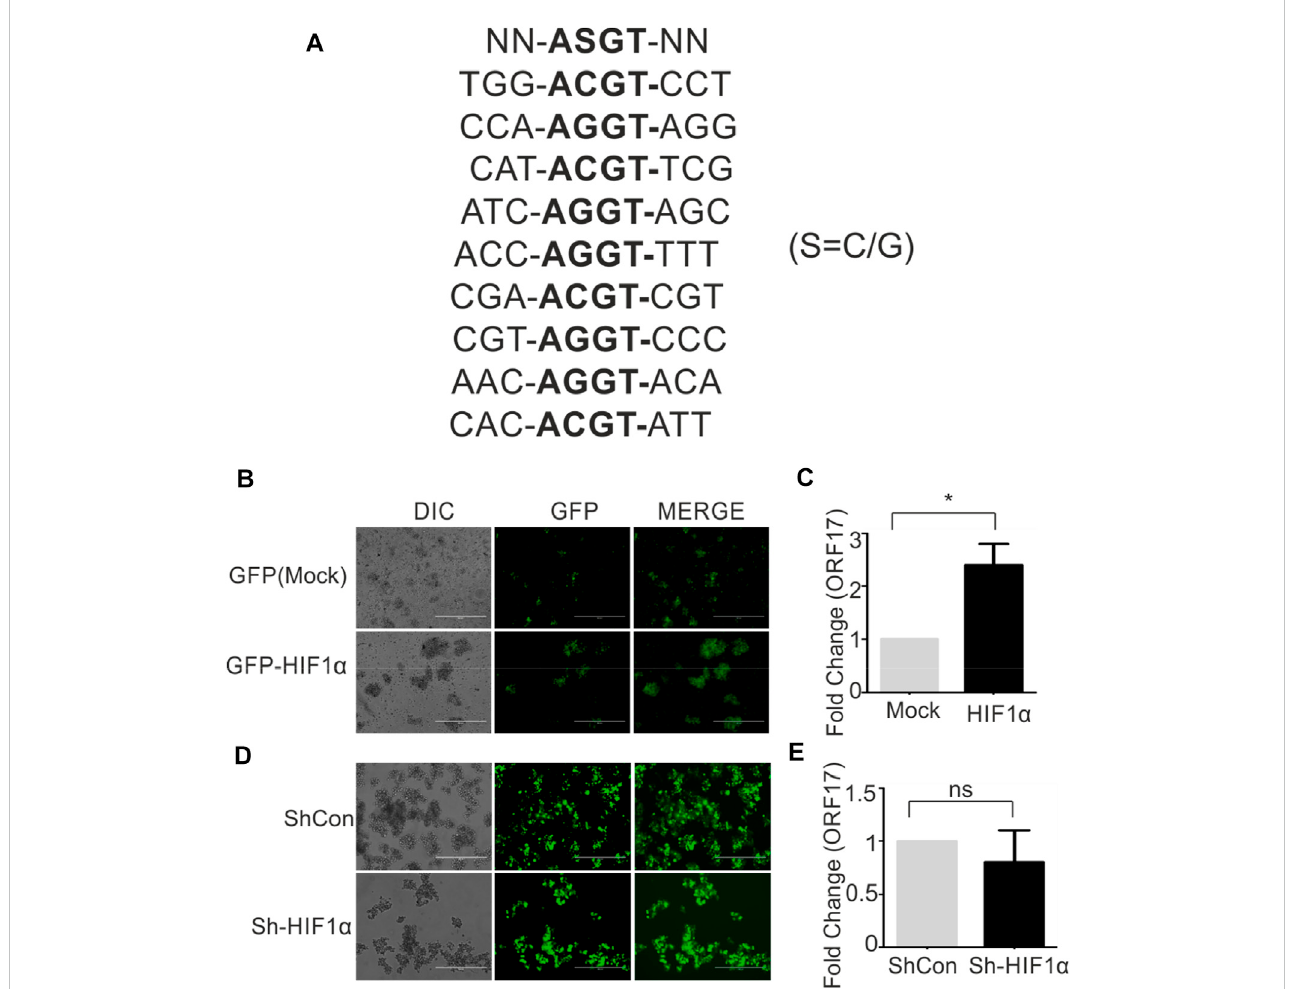
FIGURE 2 HIF1 α can directly up-regulate expression of KSHV-encoded ORF17. (A) Presence of nine distinct hypoxia responsive elements (HREs) within 1,000 bp upstream of ORF17. NN-ASGT-NN represents HRE consensus sequence (S=C/G). (B) BC3 cells stably expressing Mock (GFP) or GFP-HIF1 α . The expression was visualized by fl uorescent microscopy. (C) A comparative study for real-time expression of ORF17 in mock or HIF1 α expressing BC3 cells (* denotes p < 0.05). (D) BC3 cells stably expressing ShControl or ShHIF1 α transcript. The expression wasvisualized by fl uorescentmicroscopy. (E) A comparativestudy for real-time expression of ORF17 in expressing ShControl or ShHIF1 α expressing BC3 cells (ns = non-signi fi